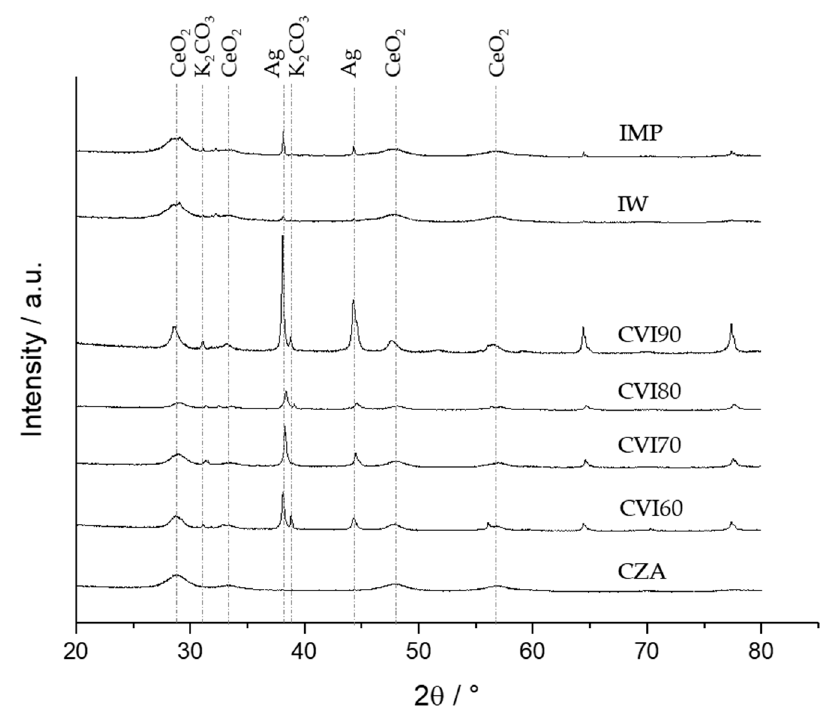
Figure 5. Powder X-ray di ff raction patterns for all catalysts and for the ceria-zirconia-alumina (CZA) support.